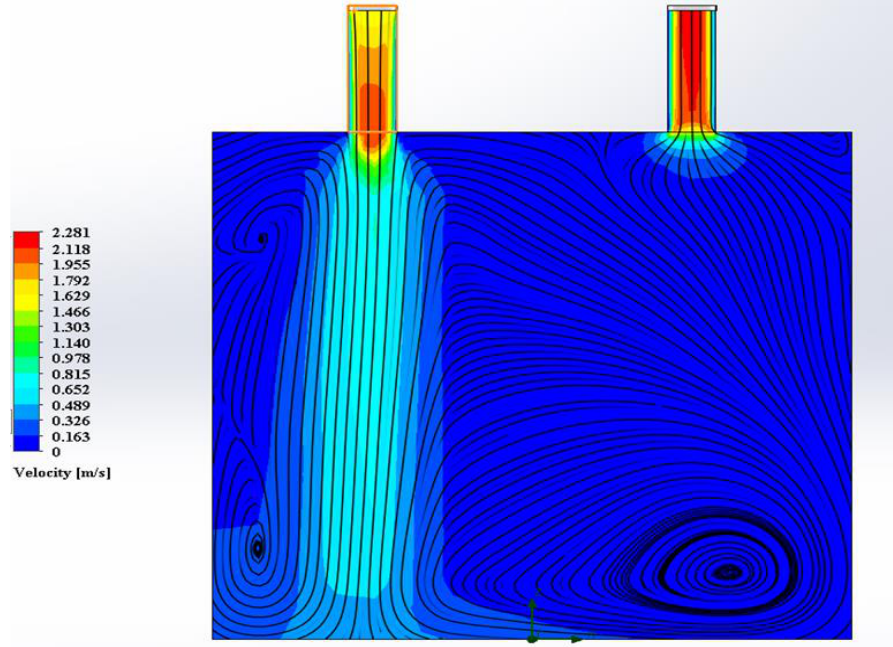
Figure 14. Air velocity in reaction cell and current lines, in run 1, for the geometry with upper air